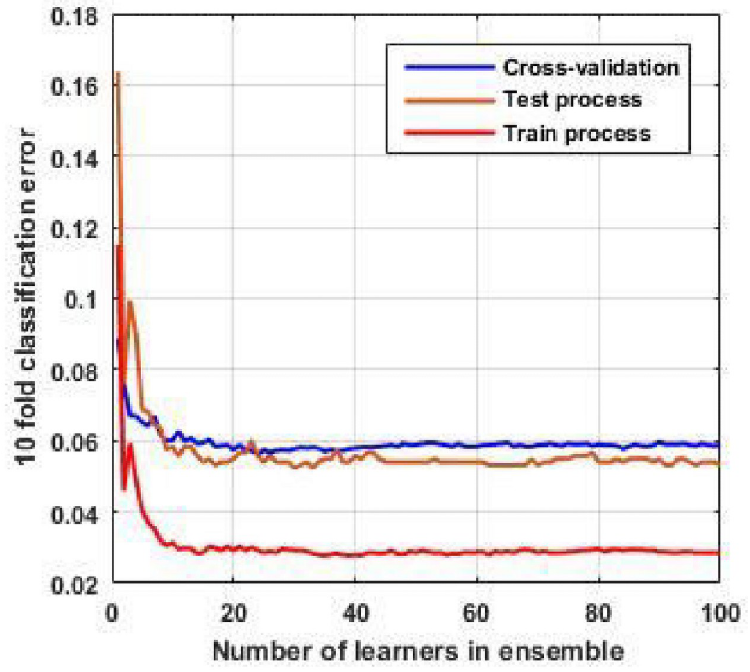
Fig 9. Error classification for KNN random subspace method. This curve indicates the performance of the algorithm.